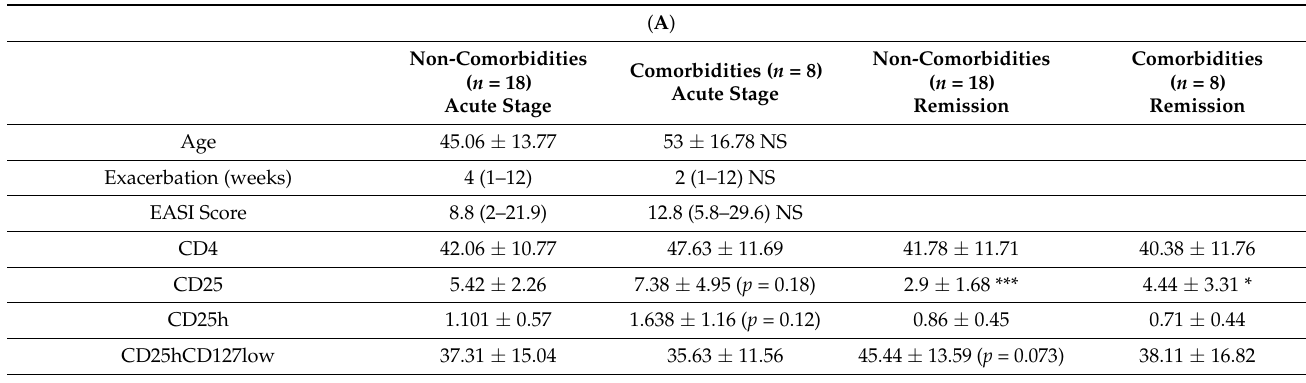
Table 4. ( A ) Comparison of selected variables in ACD patients depending on presence of comorbidi- ties. ( B ) Correlations of the percentage of iOPN CD4 lymphocytes with selected variables in the ACD patients depending on presence of